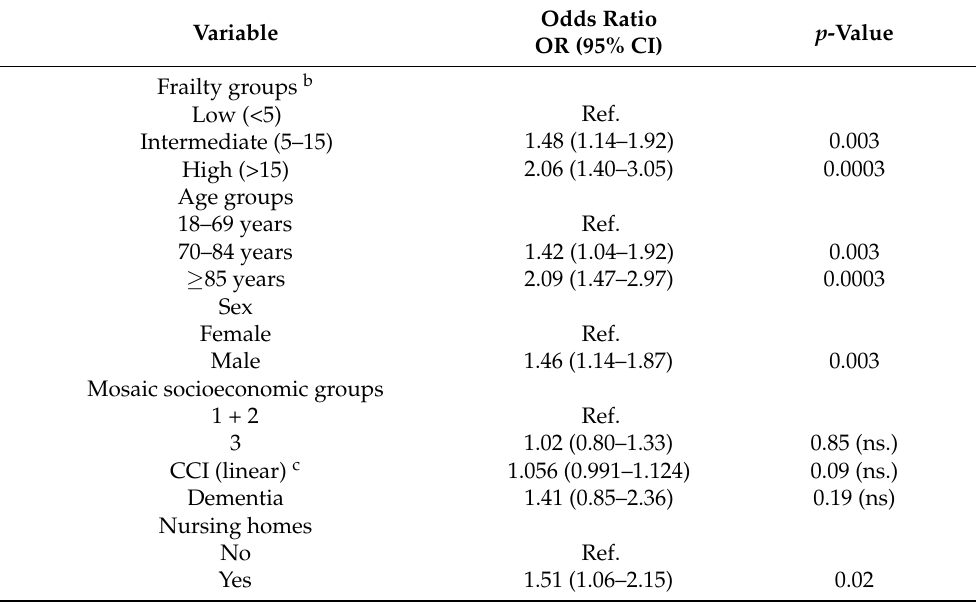
Table 2. Odds ratios (ORs) (univariable analysis) for the probability of dying with COVID-19 within 30 days of diagnosis. N = 4312 cases of advanced cancer a , of which 282 died with COVID-19 infection. Odds Ratio Variable